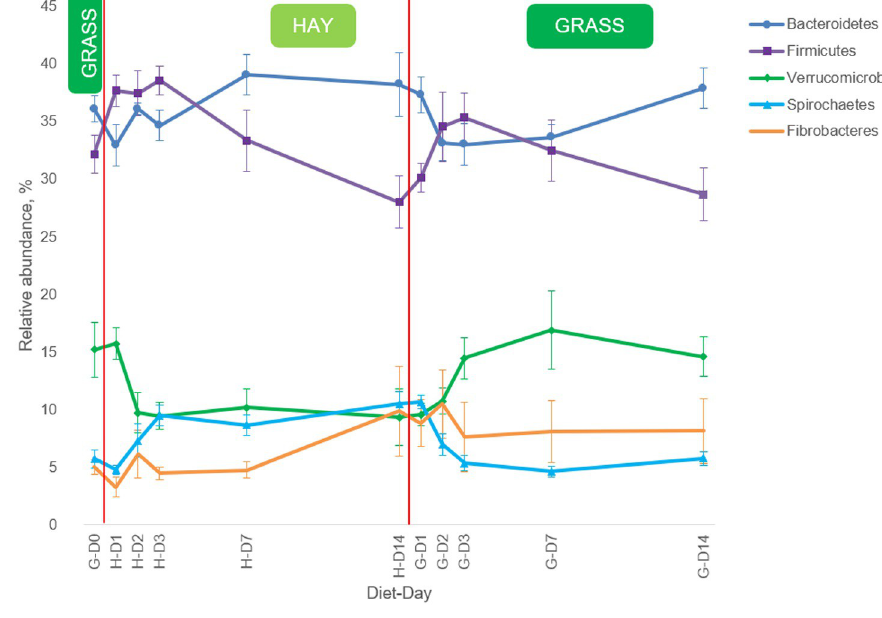
Fig 5. Bacterial phyla dynamics in the faeces of the ponies during the abrupt dietary transitions. Bacterial phyla with relative abundance > 5% are presented. Error bars represent standard error of the mean. Red vertical lines represent abrupt changes in the diet. D: day; H: hay; G: